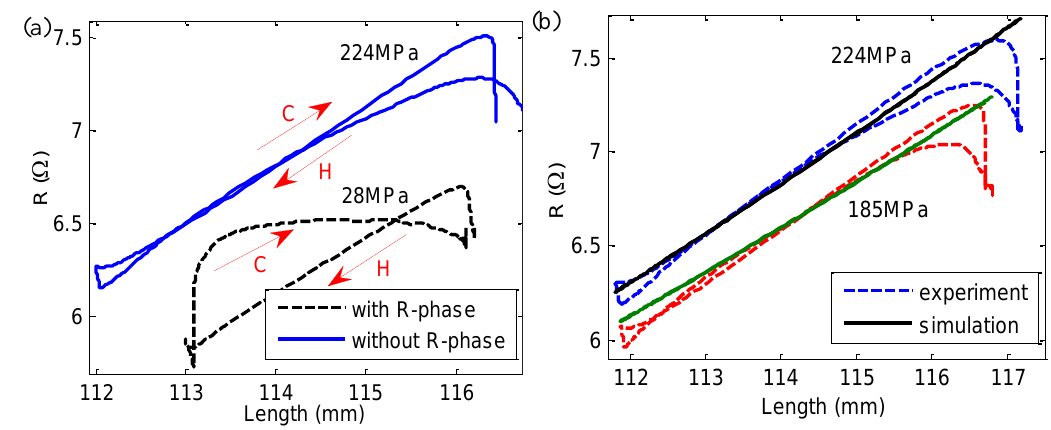
Figure 10. experimental and simulation results of R-L